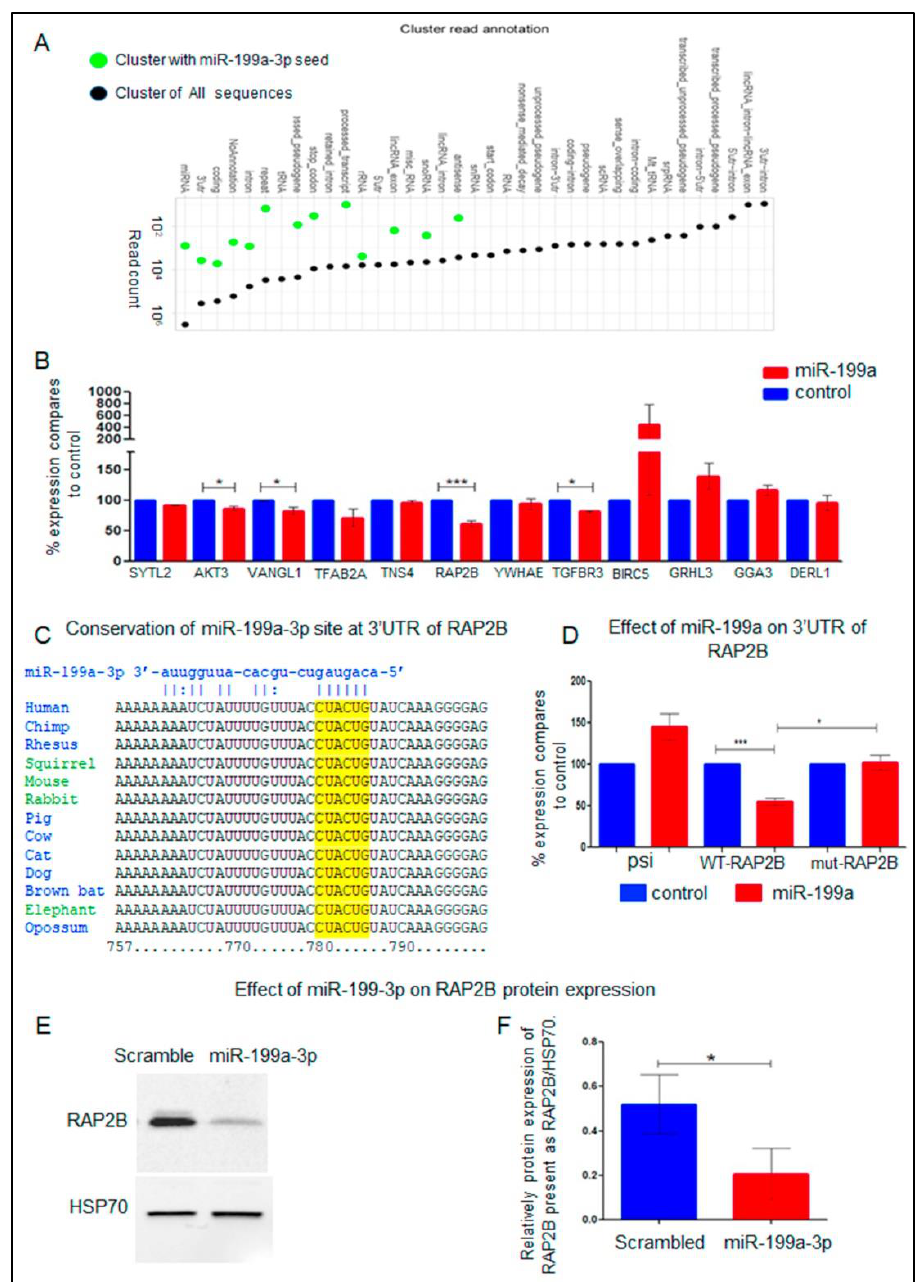
Figure 4. Summary of PAR-CLIP Ago2 assay and RAP2B is a biochemical target of miR-199a-3p. ( A ) Genomic distribution of Argonaute 2 binding sites in transcript regions. Black = all cluster-assigned PAR-CLIP reads; Green = cluster-assigned PAR-CLIP reads containing miR-199a-3p complemen- tary regions. RAP2B is a biochemical target of miR-199a-3p. ( B ) SCL-II cells stably expressing miR-199a (red columns) or control vector (blue columns) were transfected with psiCHECK-II vectors with 3′ UTR of the named genes (fused to Renilla luciferase). 24 h after transfection cell lysates were subjected to a dual luciferase assay. The ratio of luminescence of renilla/firefly luciferase obtained in control cells for each gene was set as 100% and the results are the ratio of expression of renilla/firefly luciferase in cells expressing miR-199a-3p relative to controls. The mean ± SD was calculated from 3 independent experiments. Statistics were performed with t -tests * p < 0.05, *** p < 0.001. ( C ) The con- servation of a RAP2B 3 (cid:48) UTR region that contains a putative miR-199a-3p binding site and was pulled down in the PAR-CLIP assay is shown in mammals. ( D ) SCL-II cells stably expressing